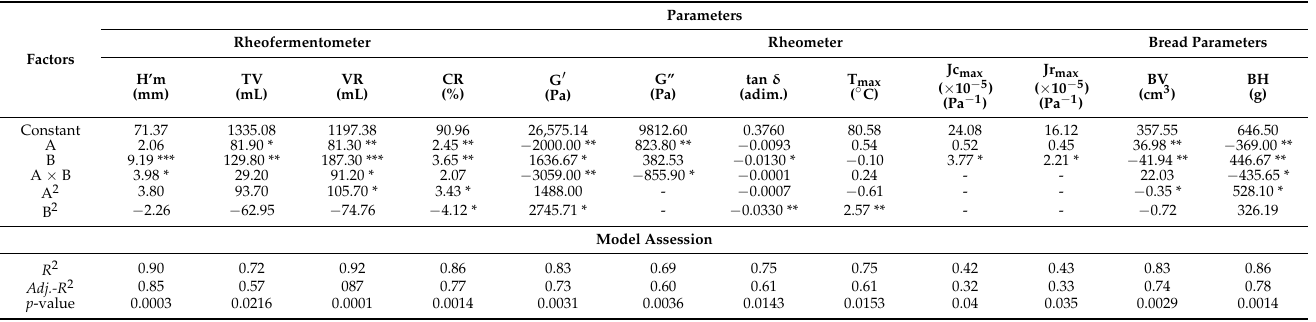
Table 3. ANOVA results of the models fitted for dough rheofermentation, and dynamic rheological and bread characteristics.